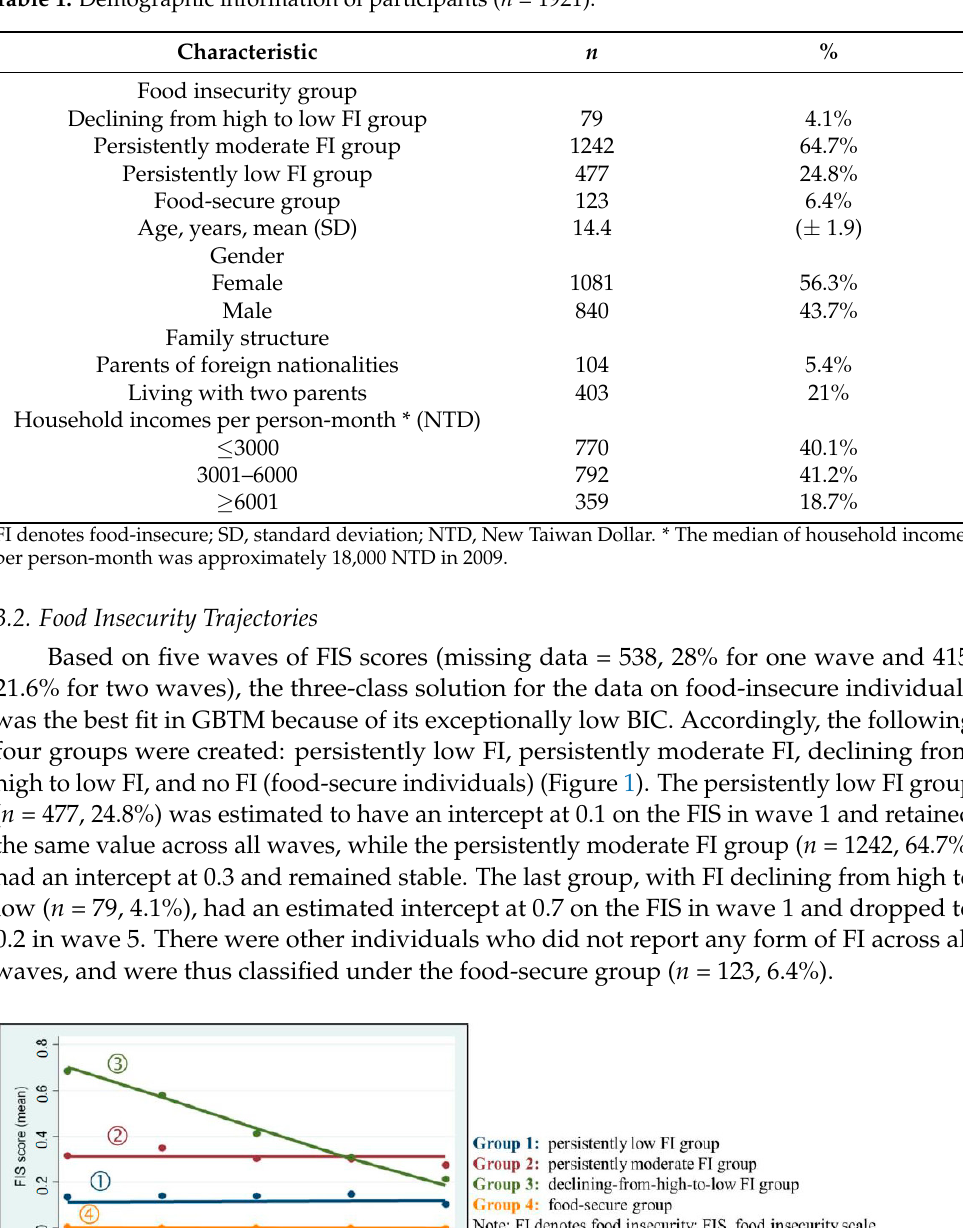
Table 1. Demographic information of participants ( n = 1921).